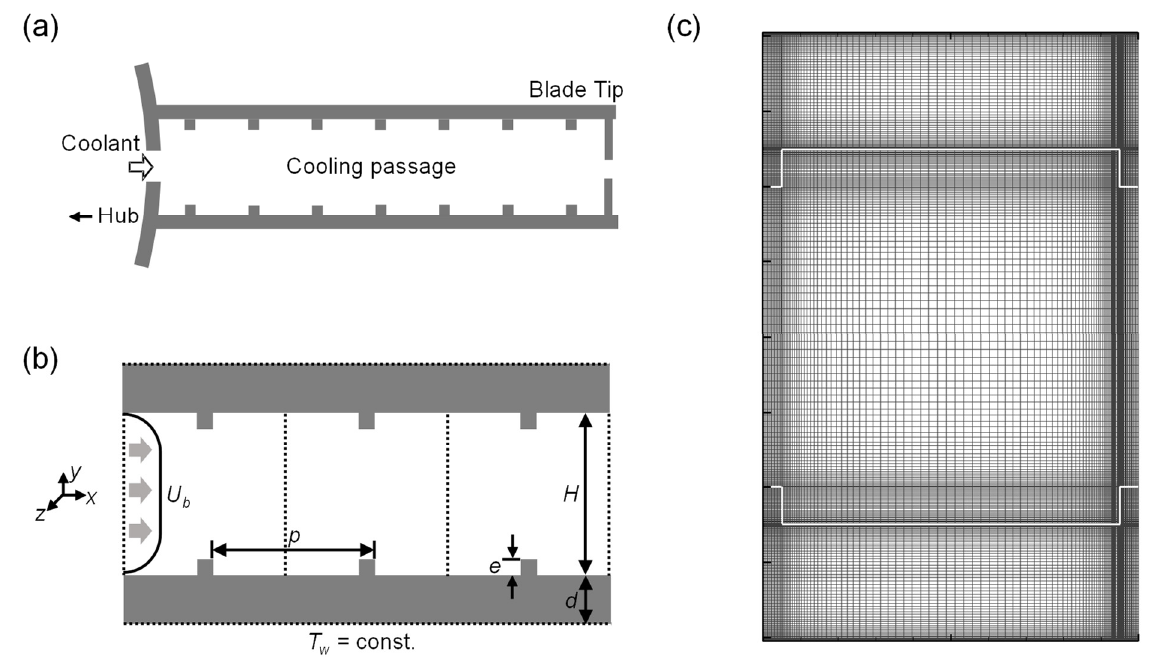
Figure 1. Computational domain and grid system: ( a ) schematic diagram of the internal cooling passage; ( b ) the computa- tional domain; and ( c ) the grid system.